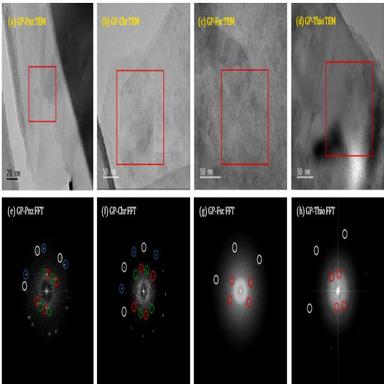
TEM images and their Fast Fourier Transformations (FFTs) for the samples: (a) GP-Pnz TEM image; (b) GP-Chr TEM image; (c) GP-Fsc TEM image; (d) GP-Thio TEM image; (e) GP-Pnz FFT image; (f) GP-Chr FFT image; (g) GP-Fsc FFT image; (h) GP-Thio FFT image. The areas used to calculate FFT power spectra (e-g) are indicated by a red square in the corresponding TEM images (a-d).